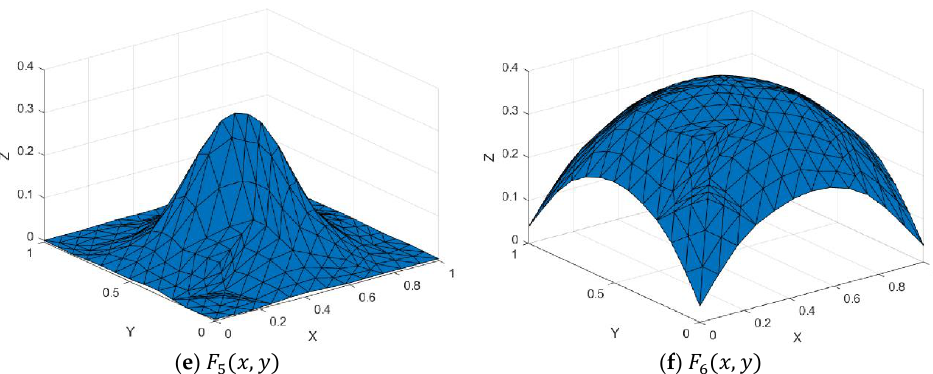
Figure 12. Surface interpolation using Goodman and Said method and Choice 1 for 36 datasets.